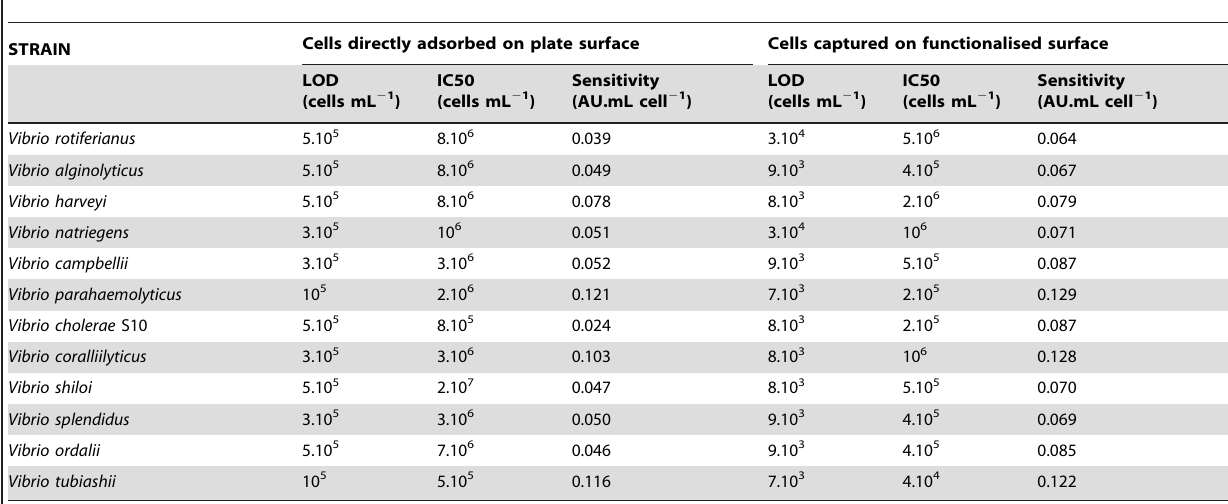
Table 2. LOD, IC50 and sensitivity values obtained for each Vibrio strain with or without functionalising the plate surface.